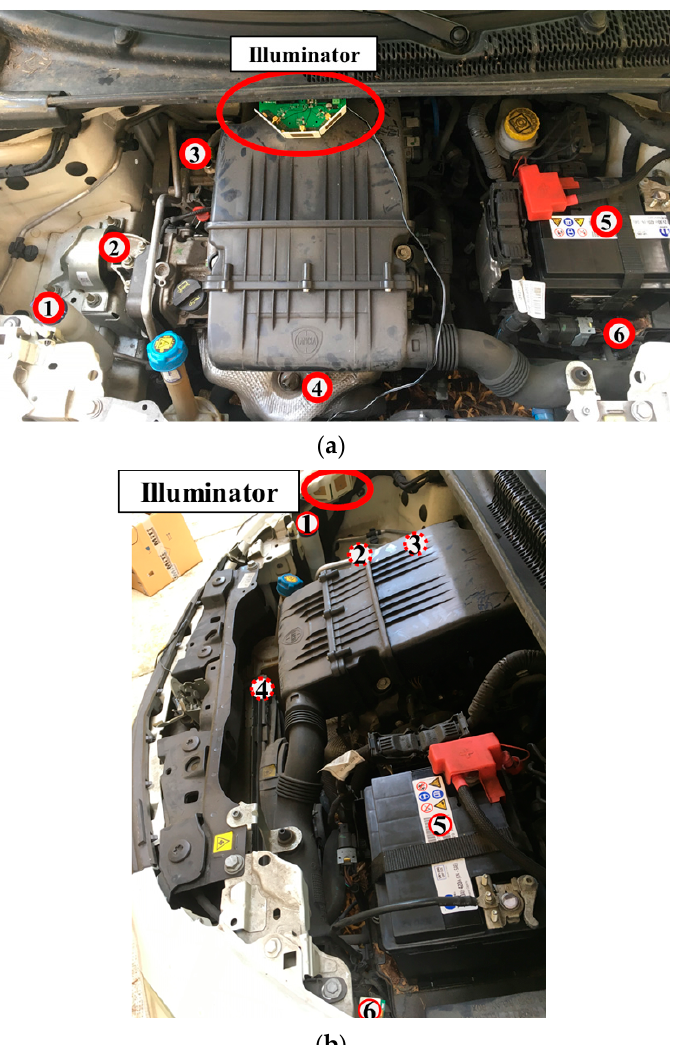
Figure 10. Front and side views of the scenario under test. The RF illuminator and the six positions of the sensors are highlighted both for setup 1 ( a ) and setup 2 ( b ).